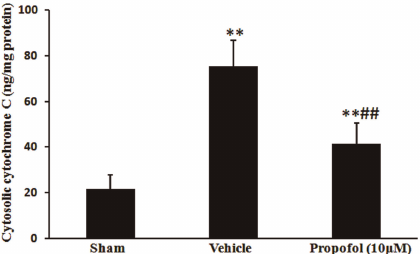
Figure 3. Effect of propofol on burn serum-induced cytochrome C release. Burn serum induced translocation of cytochrome C from mitochondria into the cytosol. Propofol pretreatment significantly inhibited this translocation. Data are reported as means±SD (n=5 in each group). **P , 0.01, compared to the sham group; ## P , 0.01 compared to the vehicle group (one-way ANOVA).